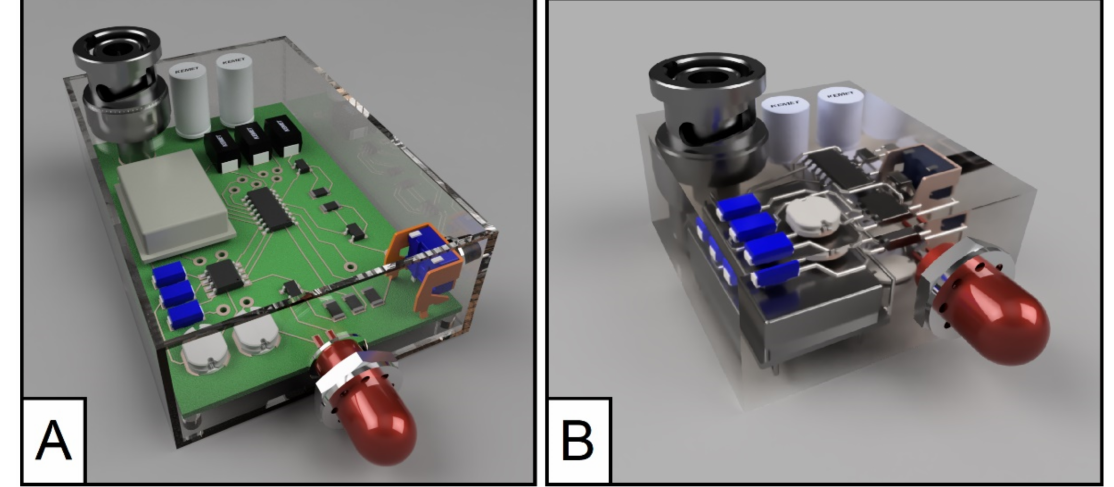
Figure 1. Example electronic device made traditionally ( A ) and as structured electronics ( B